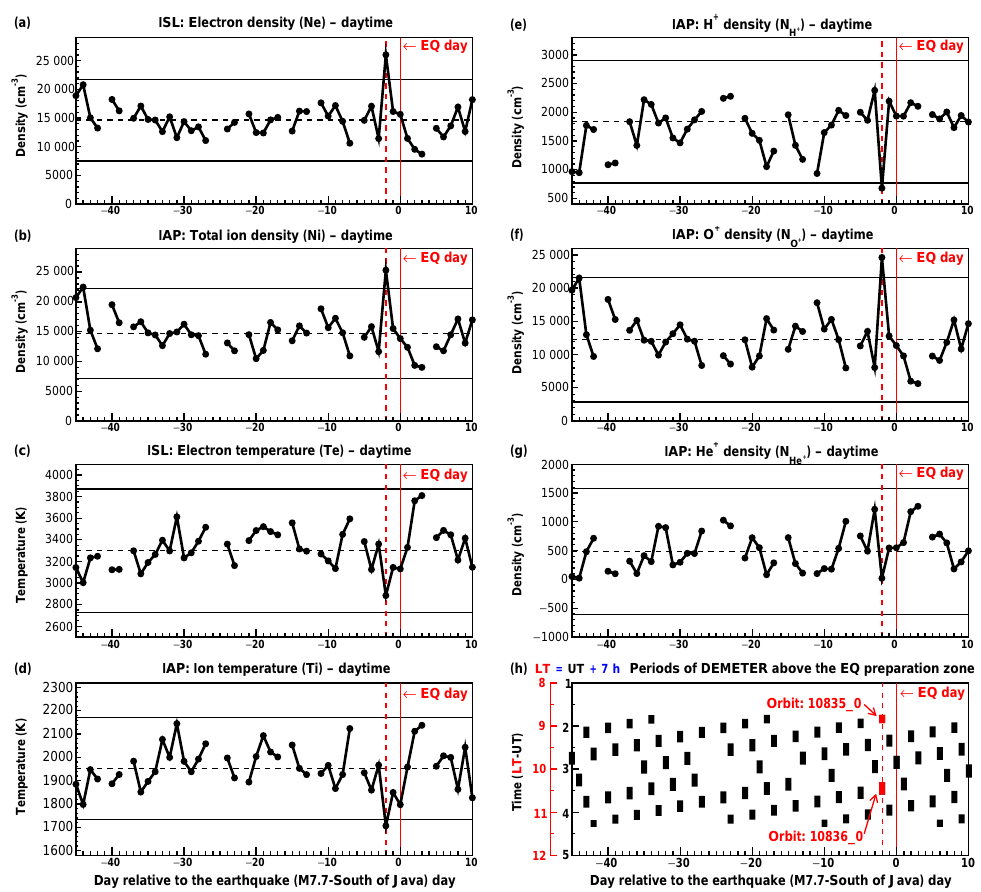
Figure 7. Plasma parameter anomalies above the earthquake preparation zone from 2 June to 27 July 2006. (a) Electron density and (c) elec- tron temperature derived from the measurements of the ISL in the daytime. (b) Total ion density and (d) ion temperature, (e) H + , (f) O + and (g) He + density derived from the measurements of IAP in the daytime. Since the DEMETER satellite sometimes did not pass over the earthquake preparation zone in the daytime, there are some time gaps. The black dashed lines indicate the median value ( M 56 ) and the two black solid lines indicate the upper and lower bounds ( M 56 ± 2 . 0 · IQR ) . (h) The periods during which DEMETER satellite passed over the earthquake preparation zone in the daytime ( ∼ 09:00–10:30LT). The x axis represents the day relative to the earthquake day. The earthquake day and day 2 before the earthquake are represented by red vertical solid and dashed lines,